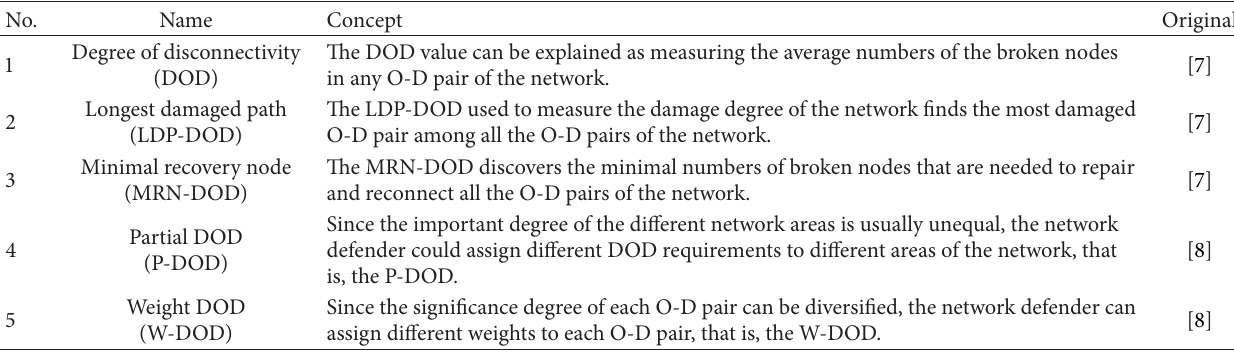
Table 1: The summary of different DOD